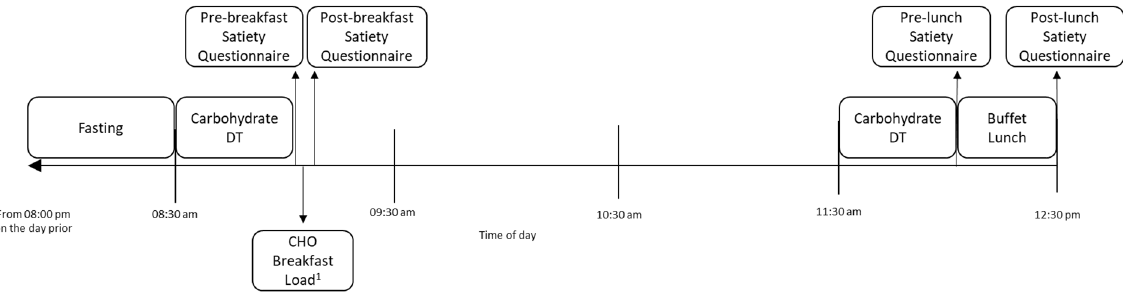
Figure 1. Study timeline for sessions 2–4.